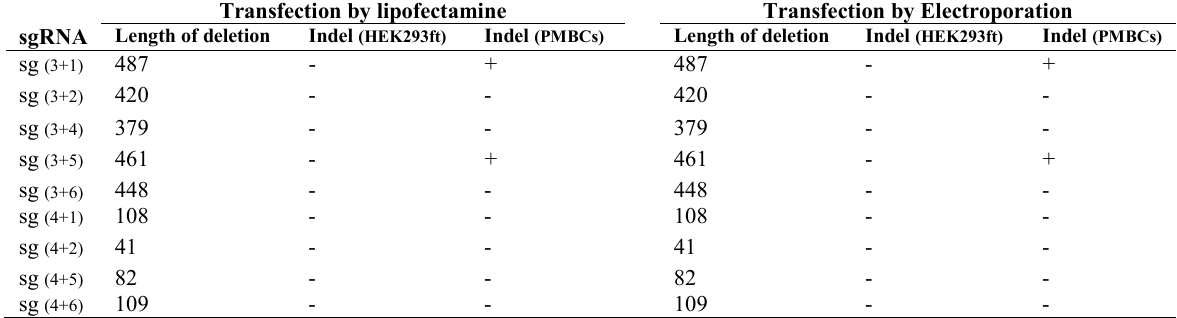
Table2. Comparison of lipofectamine and electroporation.